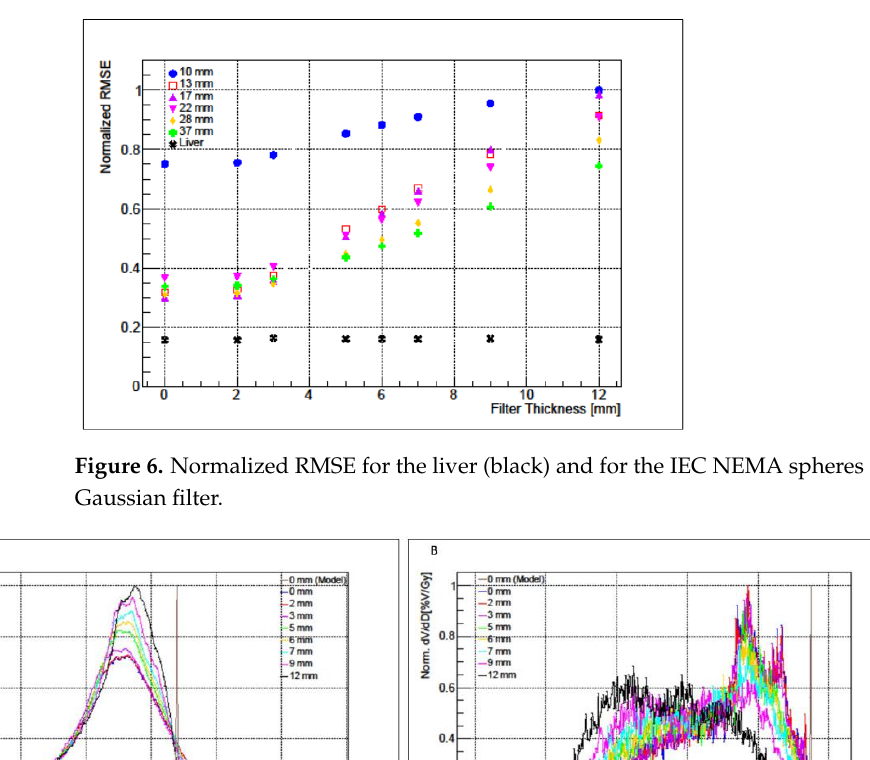
Figure 5. Integral Dose–Volume Histograms (iDVHs) for whole liver compartment ( A ) and for the 37 mm sphere ( B ), obtained with different Gaussian filters. Mean absorbed doses and respective standard deviations are also reported.